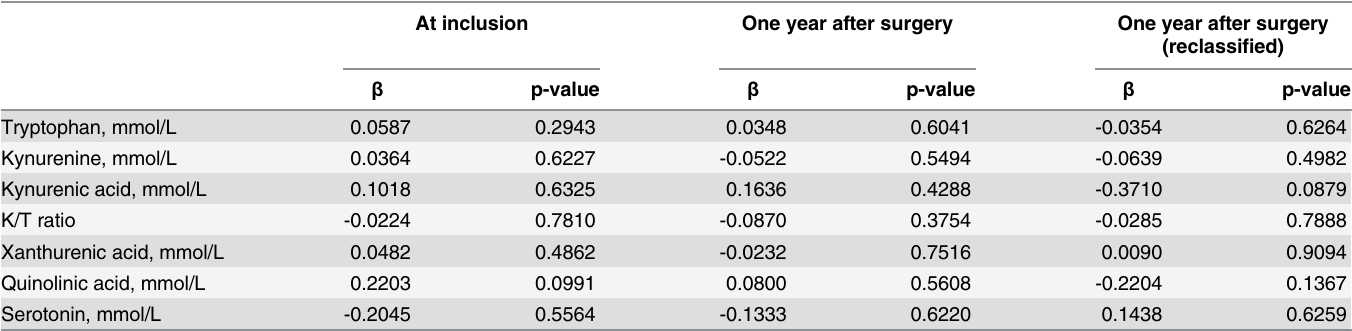
Table 3. Association between diabetic status and serum concentration of metabolites and K/T ratio, at inclusion and one year after surgery. One year after surgery, analysis was performed first according to women diabetic status at inclusion and then according to their diabetic status after